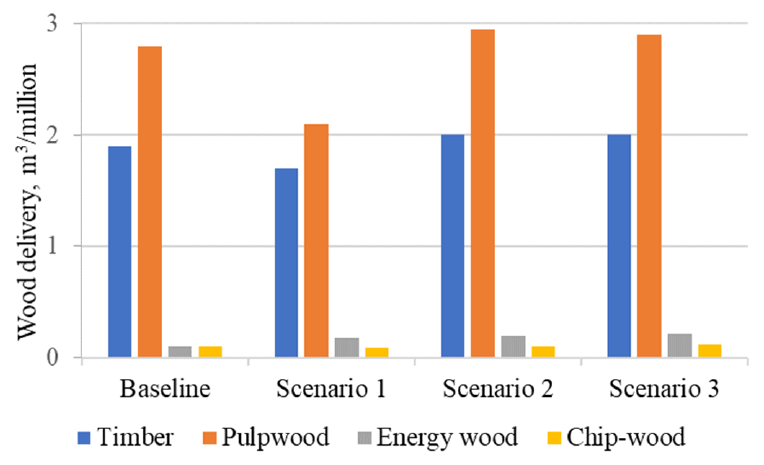
Figure 3. Comparison of wood delivery relations by wood assortments in the scenarios.